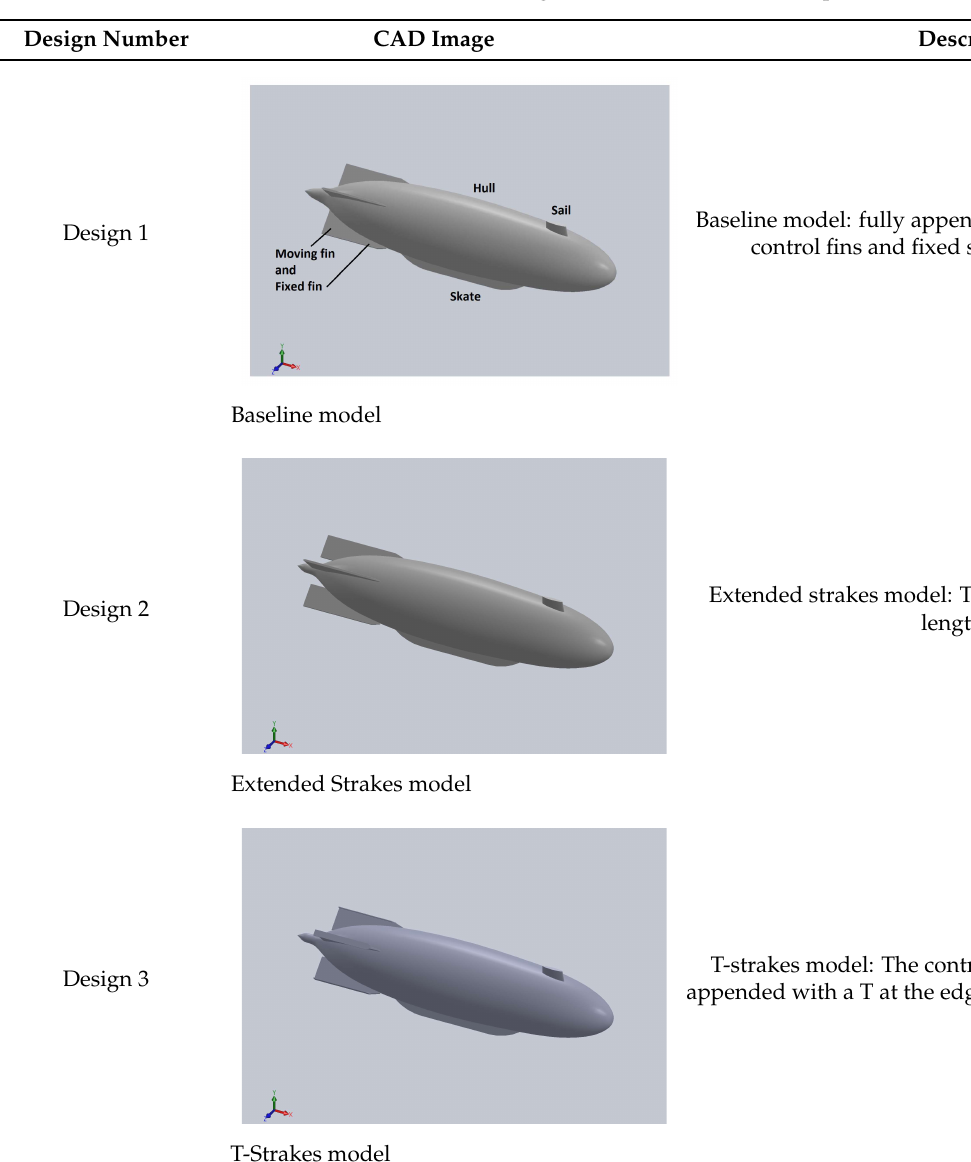
Table 4. Design iterations and their